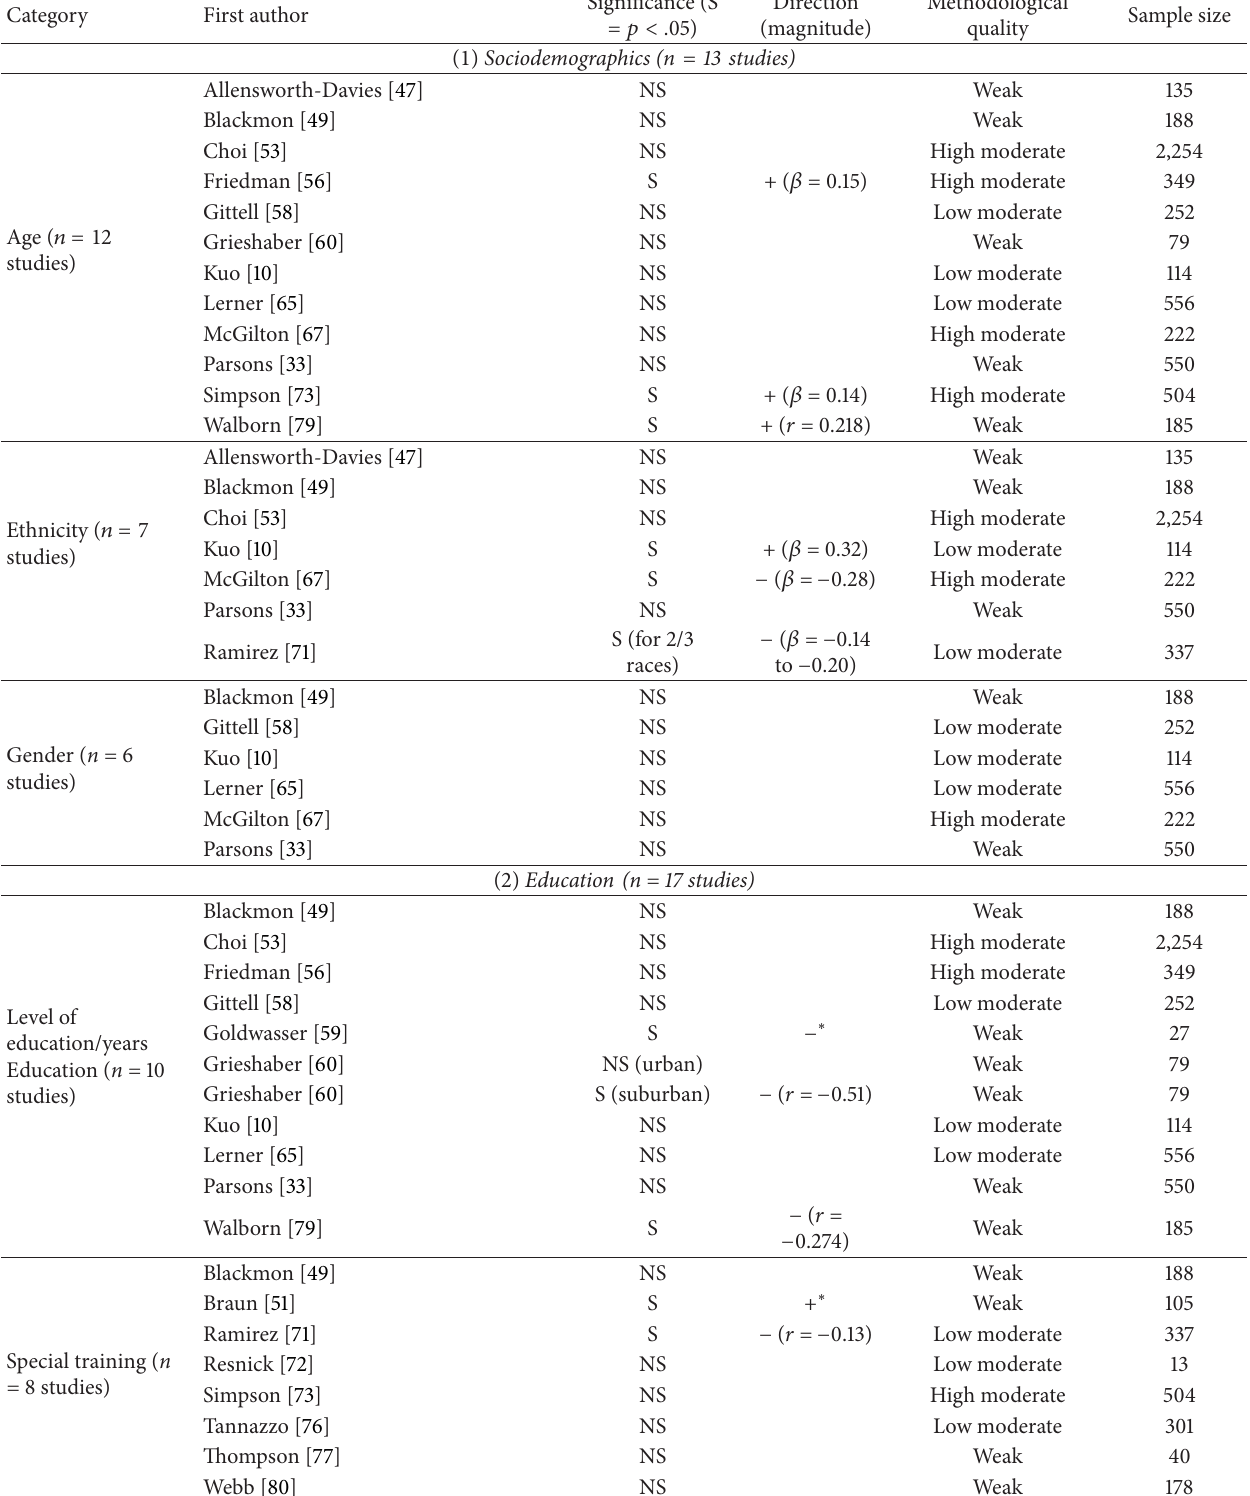
Table 3: Individual factors (reported four or more